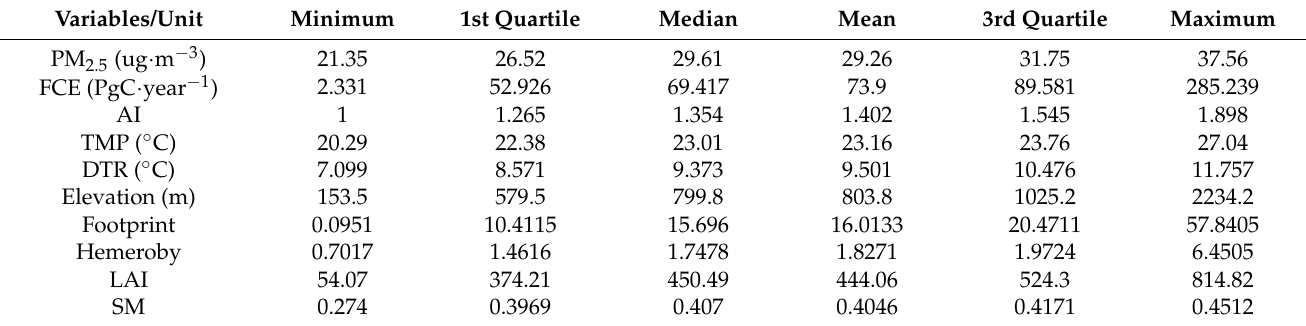
Table 2. The summary statistics of the variables for the studied region. Note: FCE is the fire carbon emission, AI is the aridity index, TMP is the annual average temperature at 2 m, DTR is the average daily temperature range, LAI is the vegetation leaf area index, and SM is the soil